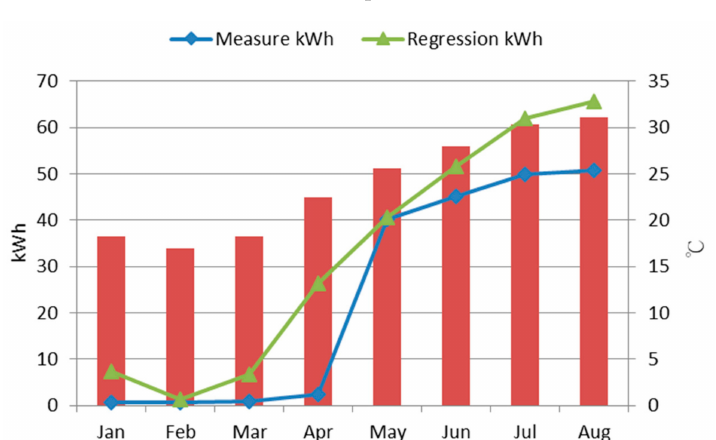
Figure 10. Energy consumption simulation of HVAC system regression